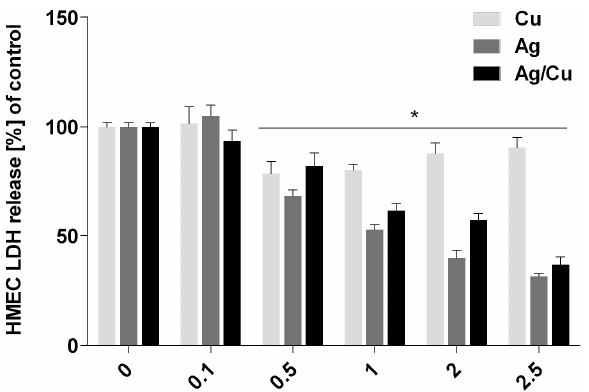
Figure 5. Viability of selected pathogen species after incubation in solutions with different concentrations of nanoparticles (NPs) (*—differences significant at p < 0.05).